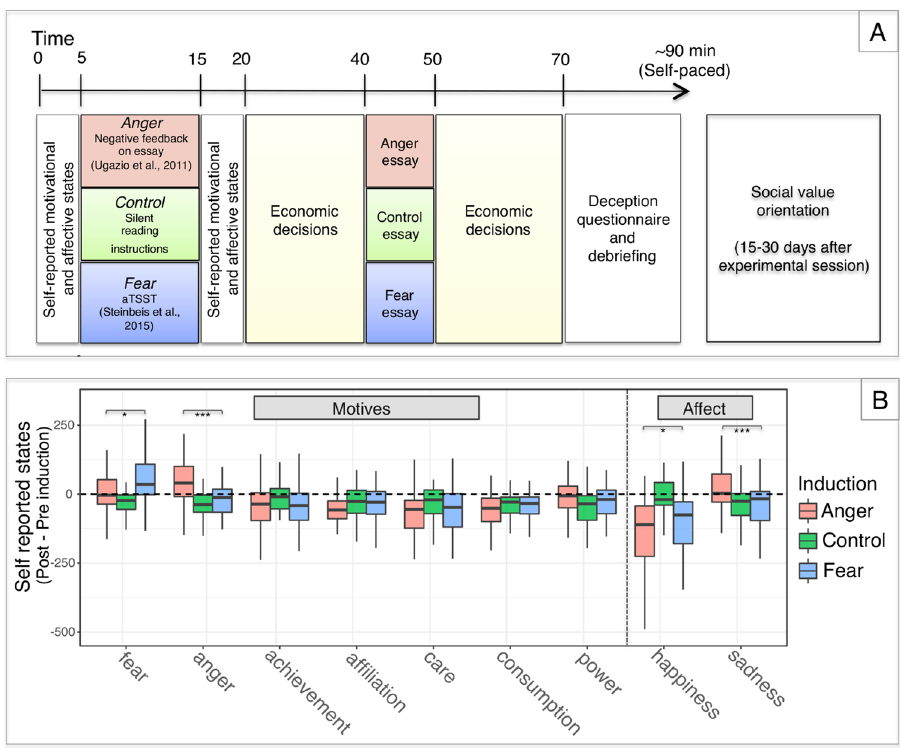
Figure 1. Panel ( A ) Experimental design. Panel ( B ) Induction validation. Planned contrasts showed that increases in anger ratings were higher in the Anger induction than in the Fear induction. Vice versa, increases in fear were higher in the Fear induction that in the Anger induction. Exploratory contrasts revealed that induced Fear and Anger also differentially elicited happiness and sadness. Ratings were provided on visual analogue scales ranging from − 350 to 350. ***p < 0.001, **p < 0.01, *p < 0.05, Bonferroni